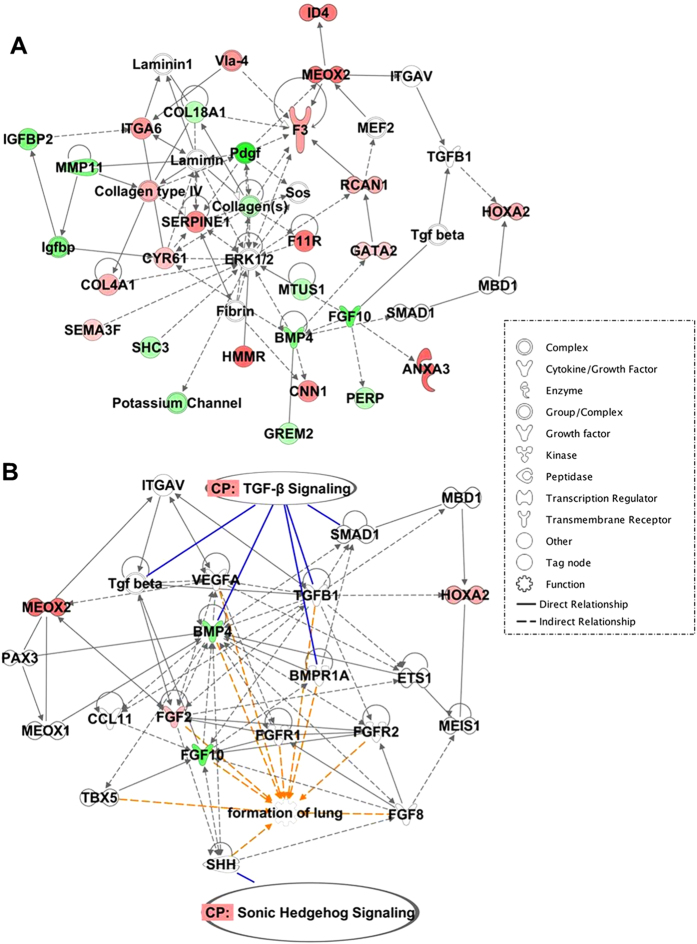
Gene interaction network of organismal development-related genes.(A) Ingenuity Pathway Analysis (IPA) was used to generate gene interaction network in progressive IPF. This network contains four developmental genes of interest (FGF-10, BMP-4, Meox2, HOxA2; Table 1). Transcriptional information was projected onto the interaction map such that up-regulated genes are depicted in shades of red and down-regulated genes are in shades of green. (B) Shortest path gene interaction network of growth factors (FGF-10 and BMP-4) and transcription regulators (Meox2 and HoxA2). IPA was used to generate this network using their Path Explorer filter which calculates the shortest path between these genes. Blue lines mark the genes found in the canonical transforming growth factor-β (TGF-β) and sonic hedgehog (SHH) signaling; whereas, orange lines indicate genes found to be involved in lung development.